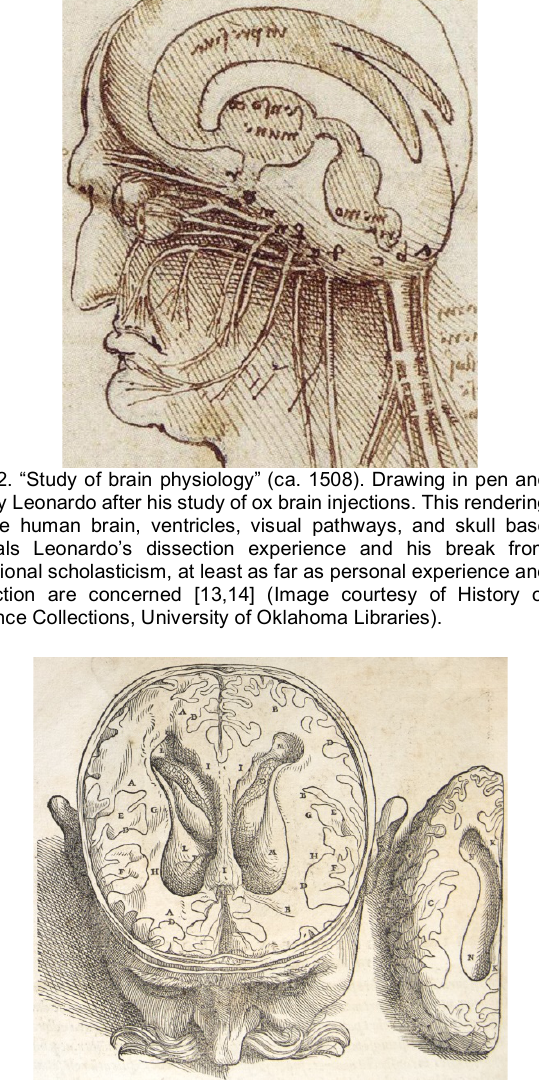
Morphological aspects Macroscopic anatomy The ventricular system is divided into two lateral ventricles, third and fourth ventricles. The lateral ventricles unite with the third ventricle through the interventricular foramen or foramen of Monro, and the third ventricle joins with the fourth ventricle through the cerebral aqueduct or aqueduct of Sylvius. Each lateral ventricle has a frontal (anterior), body, atrium, occipital (posterior) and temporal (inferior) horn (Fig. 4), and each of these parts has a roof, floor, anterior, medial and lateral walls [20,21]. Such limits are found in Table the center of the ventricular system. It communicates with the lateral ventricles through